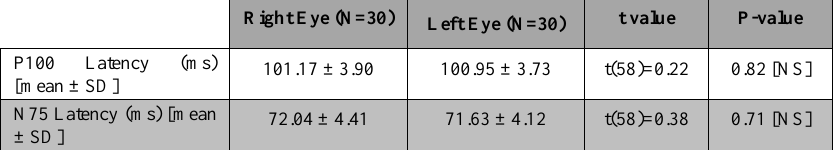
Table 8. Comparison of VEP wave latencies and N75-P100 amplitude between two eyes of